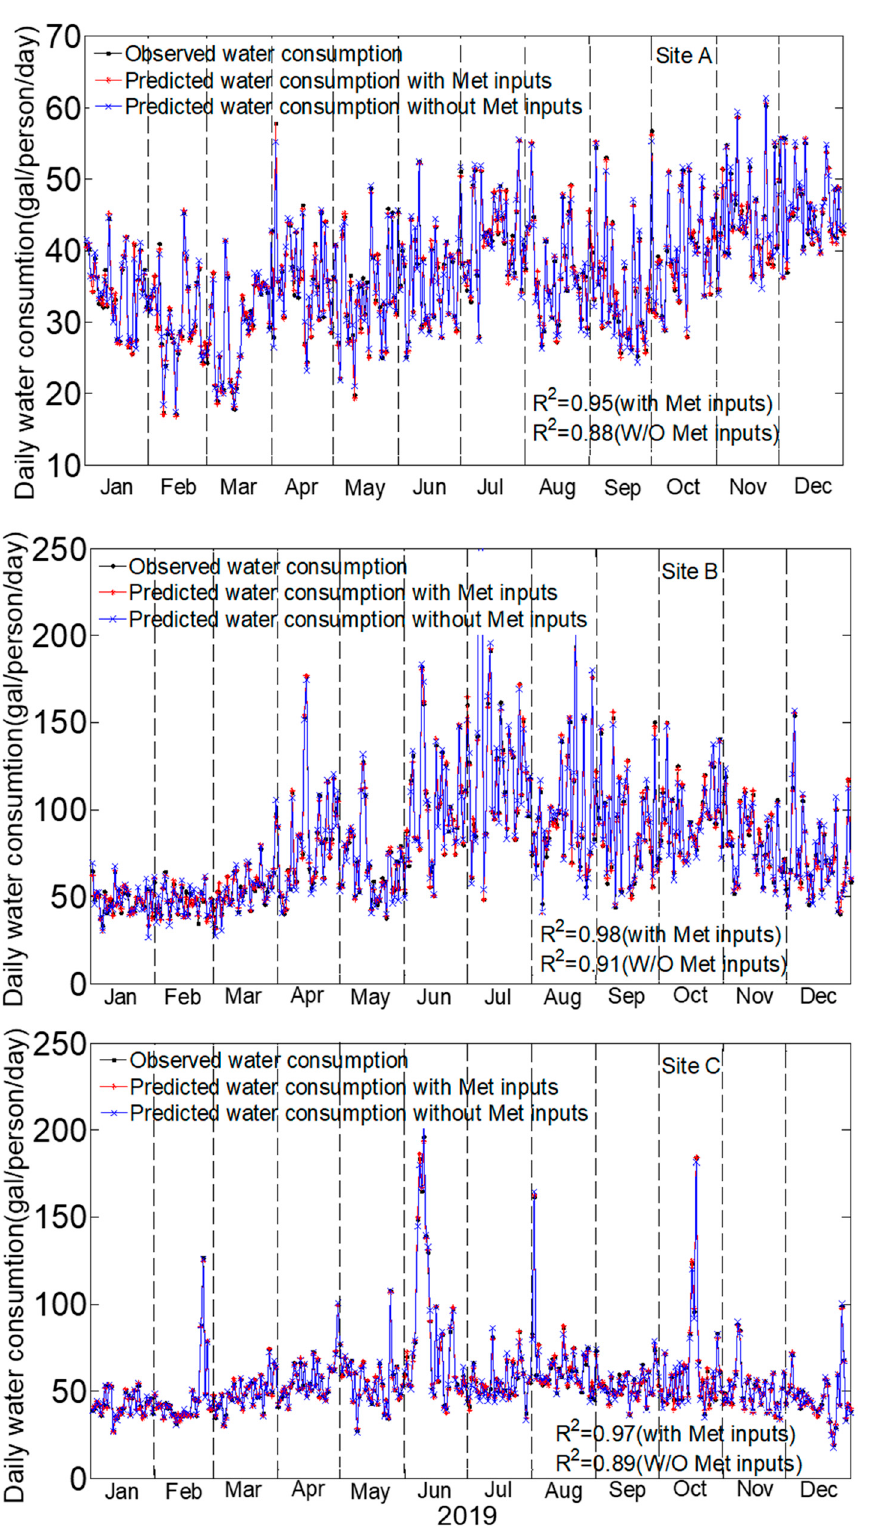
Figure 6. Illustration of model performance for daily water use (gal/person/day) for a 2019 trace of the training dataset with (red) and without (blue) meteorological inputs vs. measured water usage for the three study sites. (Met—meteorological; W/O—without). For sites { A – C }, ARMA model training was based on water use data for the periods of October 2015–June 2019, and October 2015–December 2019, respectively.